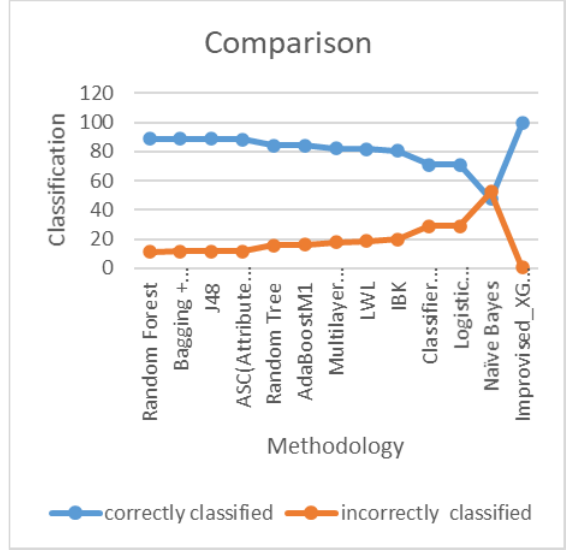
Figure 2. Graphical comparison of various methodology.